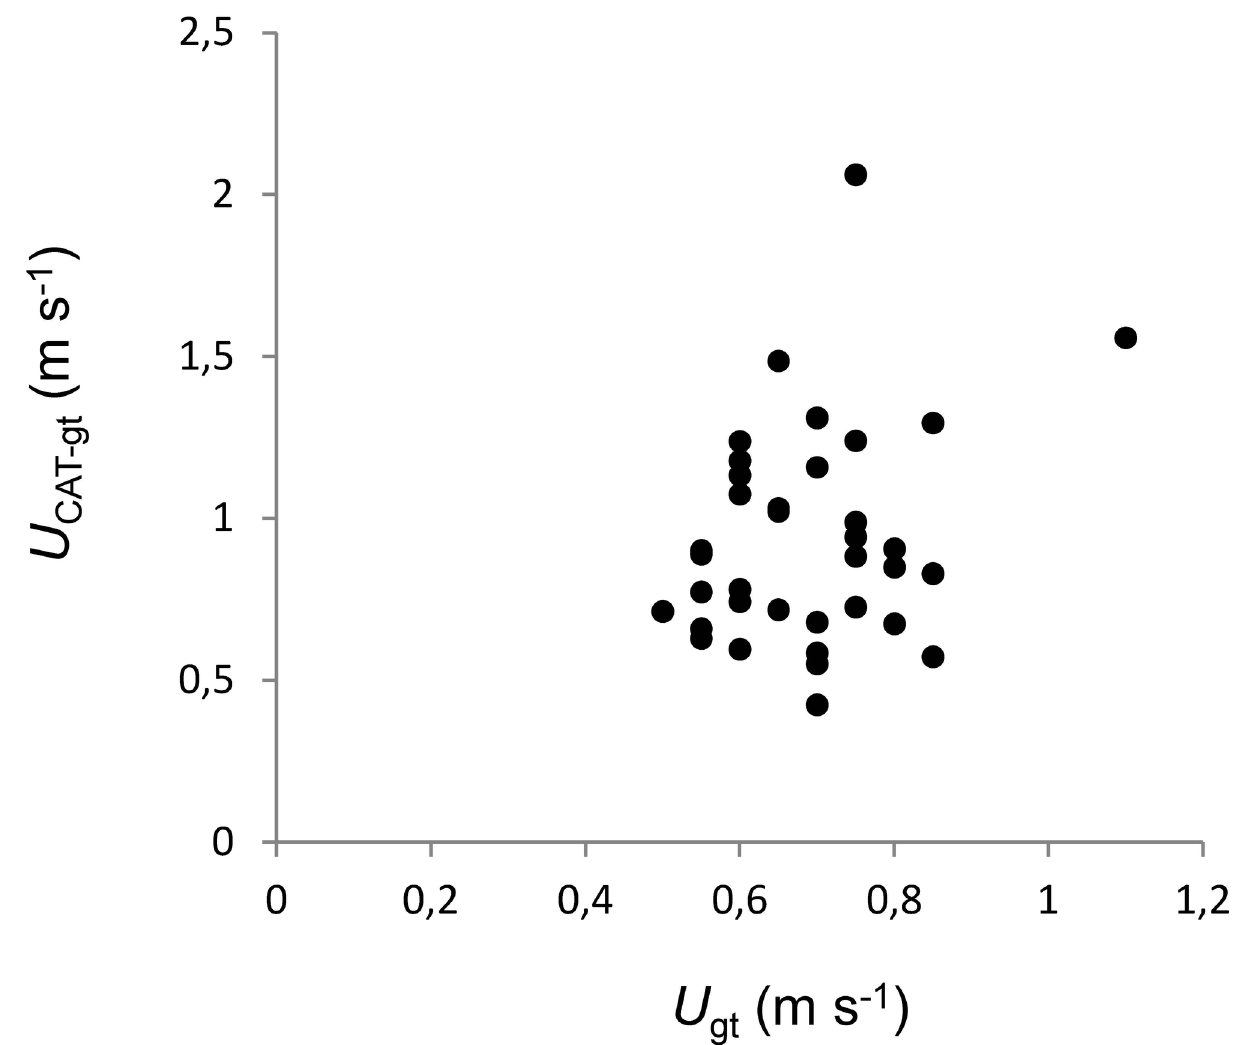
Figure 1. Relationship between aerobic gait transition speed ( U doi: